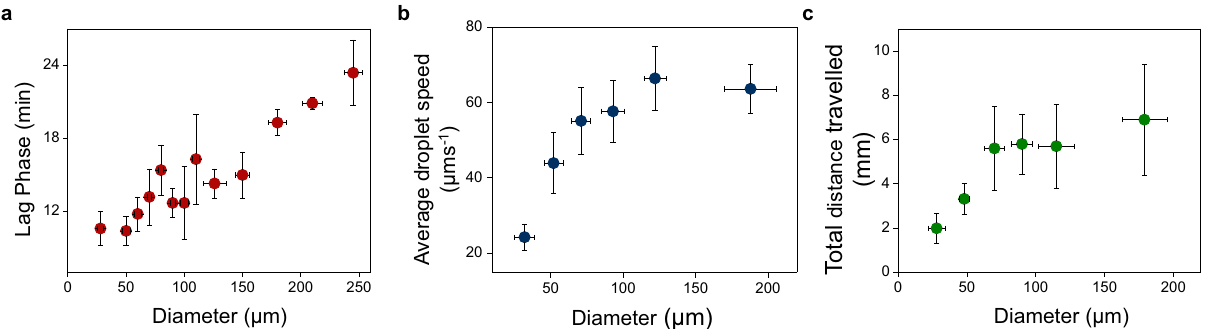
Fig. 3 Characteristics of droplet motility from lipid reproduction. a Effect of octanol droplet size on the lag phase. Each point is an average of fi ve droplets, and the error bars indicate standard deviation. b Average speed of droplets as a function of their diameter. Each point is an average of fi ve droplets, and the error bars indicate standard deviation. c Total distance traveled by octanol droplets, as a function of their diameter. Each point is an average of fi ve droplets, and the error bars indicate standard deviation.